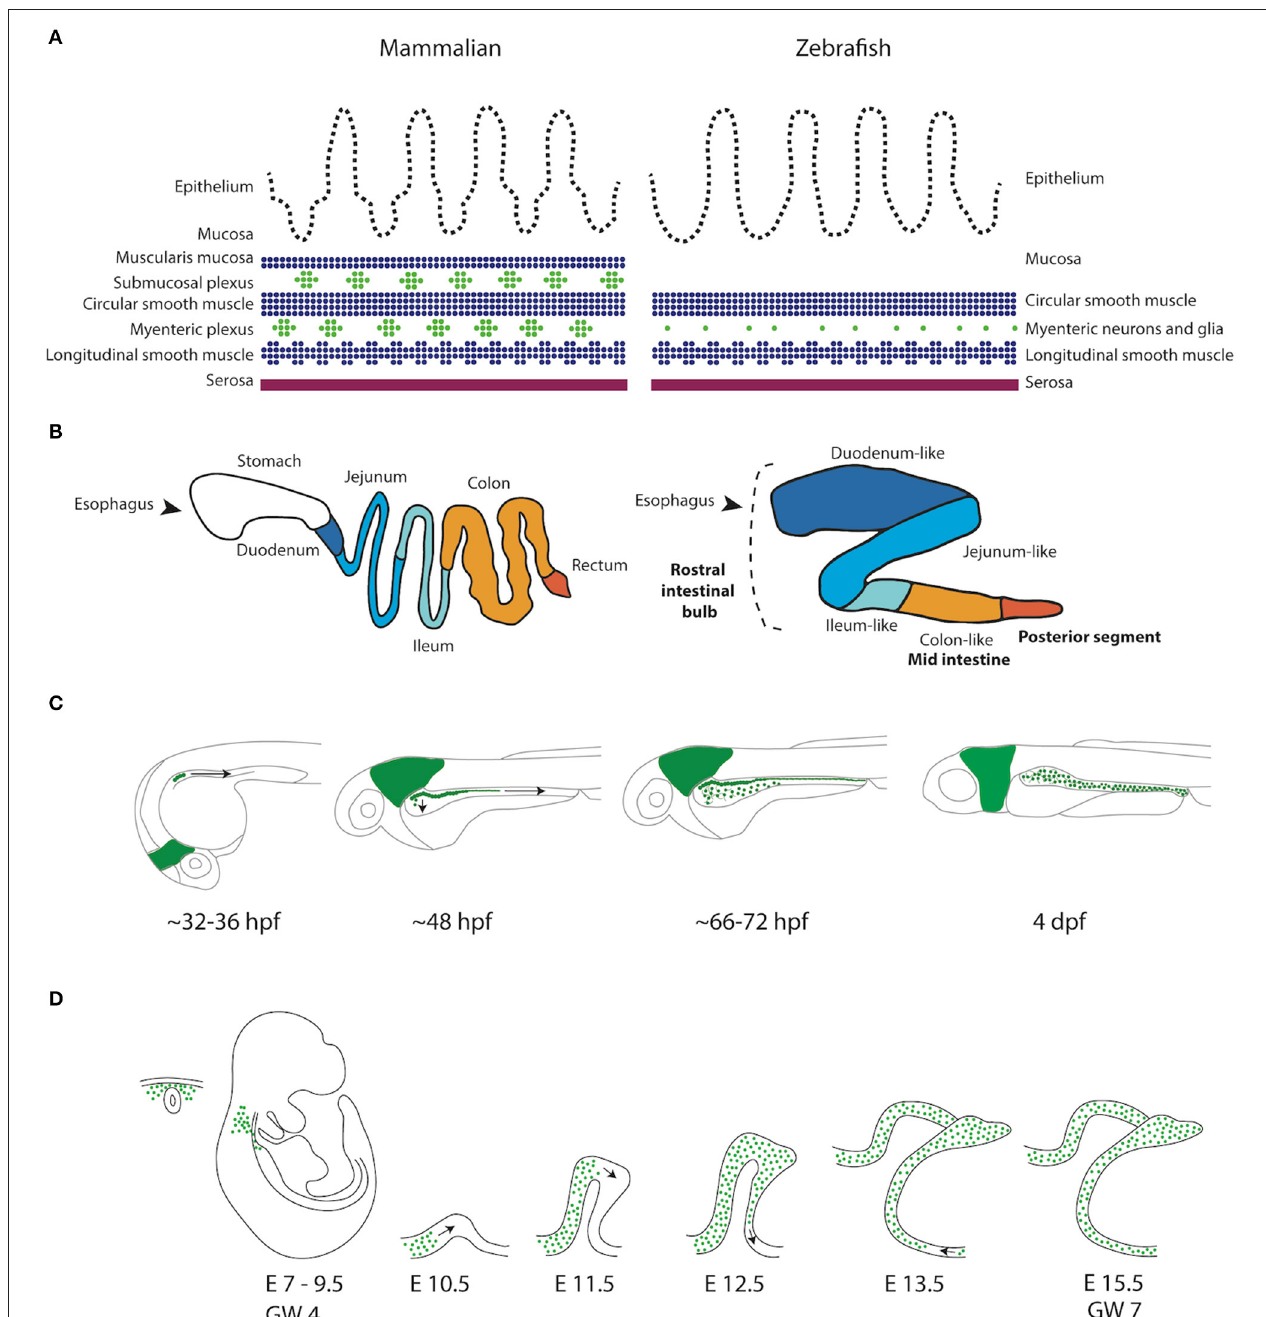
FIGURE 1 | Schematic representation of the GI tract in mammalians and zebrafish. (A) Schematic representation of the layers present in the GI tract of mammalians and zebrafish. Zebrafish lack the muscularis mucosa and submucosal plexus. In addition, the enteric neurons are not organized in ganglia, but rather as individual cells (Wallace and Pack, 2003). (B) Schematic representation of the mammalian (human) and the zebrafish digestive system. While the human GI tract is divided in stomach, duodenum, jejenum, ileum and colon, the GI tract of the zebrafish is traditionally subdivided in three major components, rostral intestinal bulb, mid intestine and posterior segment (Wang et al., 2010). A new division based on conserved transcriptional profiles has also been proposed, which is depicted by color alterations and labels in regular font (Lickwar et al., 2017). Note that boundaries between sections should not necessarily be considered discrete. (C) Schematic representation of ENS development in zebrafish showing that the NCCs depicted in green are first detected in the developing intestine around 32–36h post-fertilization (hpf). NCCs migrate in two parallel chains caudally, between 36 and 66–72 hpf. Starting rostrally, the NCCs start to migrate laterally to form a network. At 4 days post-fertilization (dpf) the ENS network has been formed around the total length of the intestine. (D) Schematic representation of ENS development in mammals. Vagal NCCs colonize the foregut at embryonic day (E)7-E9.5 in mice and gestational week (GW) 4 in humans. From E10.5, NCCs migrate caudally in various multicellular strands.